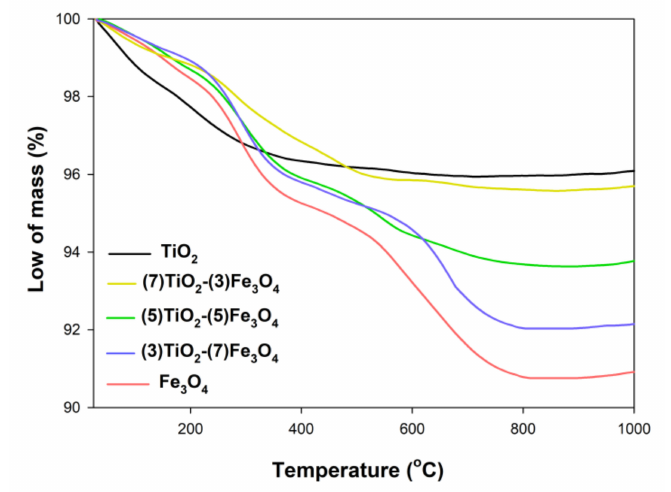
Figure 10. TGA curves for the TiO 2 -Fe 3 O 4 materials and reference